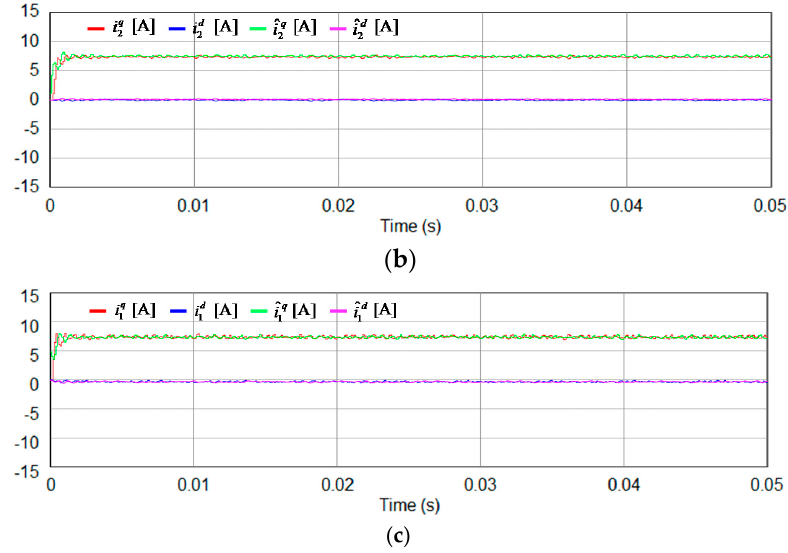
Figure 8. Simulation results for the proposed control scheme under islanding modes at the SRF. ( a ) Capacitor voltage responses; ( b ) Current responses in critical loads; ( c ) Inverter-side current responses.